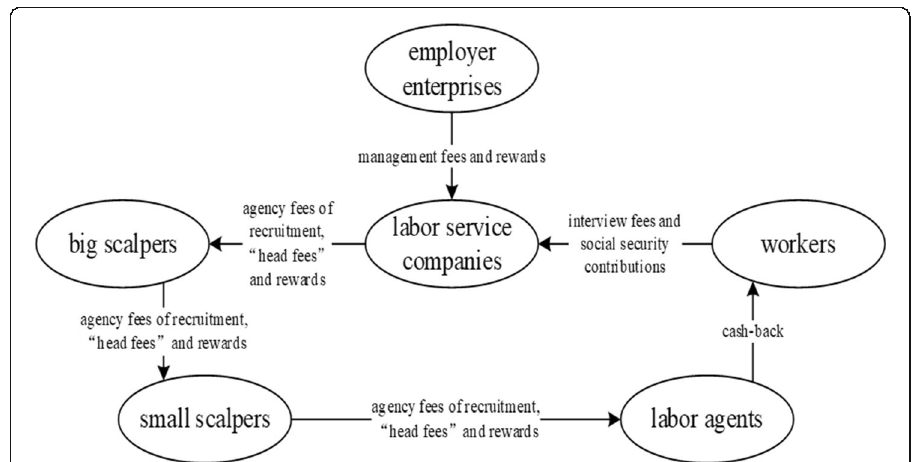
Fig. 3 The flow of money along “ factories – intermediary chain – workers